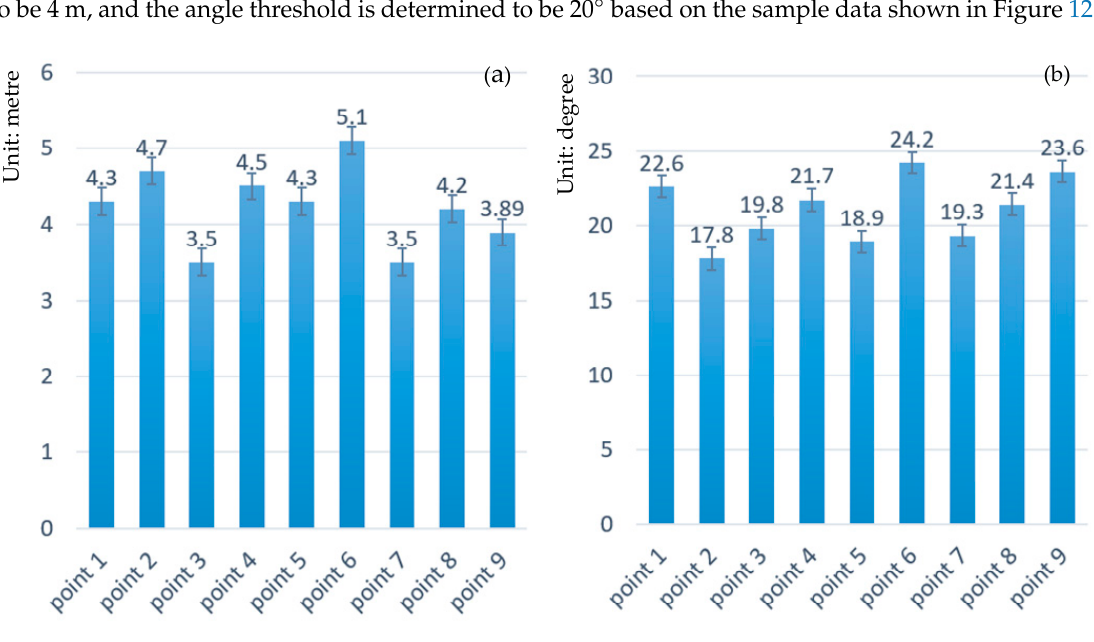
Figure 12. ( a ) The Hausdorff distance in meters and ( b ) the angle between the strokes in degrees for a sampling point.